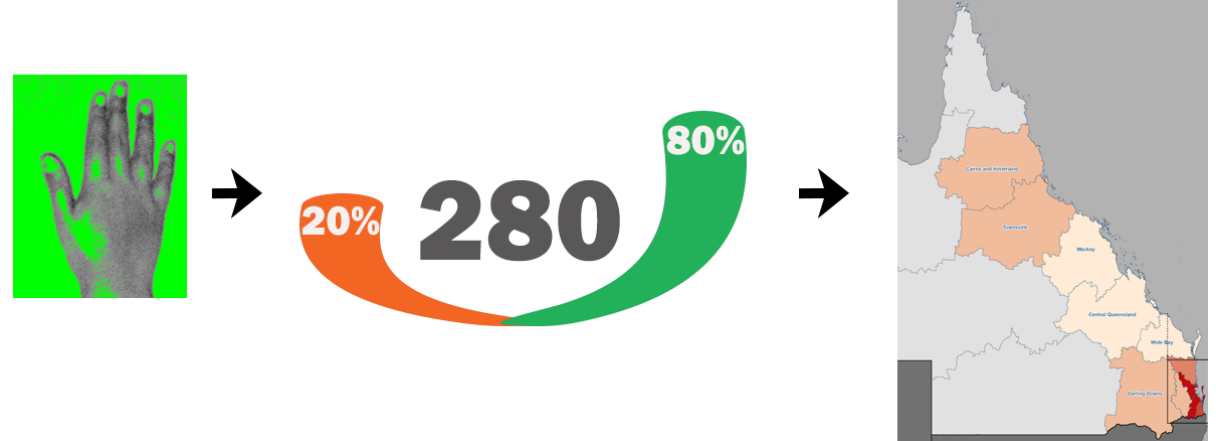
Figure 4. The flow of data from deployed smart handwashing stations to an online dashboard, overlaid with geospatial information. The smart handwashing station could collect data on hand hygiene by analyzing images and determining areas not washed sufficiently (left panel). This information could be used to generate an online dashboard (center panel) indicating the number of times the station was used, as well as the quality of the handwashing, with orange illustrating the frequency of poor handwashing and green representing good handwashing. This information could be overlaid with geospatial data from the location of the handwashing station to indicate areas with poor hand hygiene that have a potentially high risk of transmission (right panel). A graded series of colours could be used to represent risk on a map. The use of pictograms to illustrate the handwashing station data could benefit the translation of information to public health agencies and assist in the delivery of targeted public health